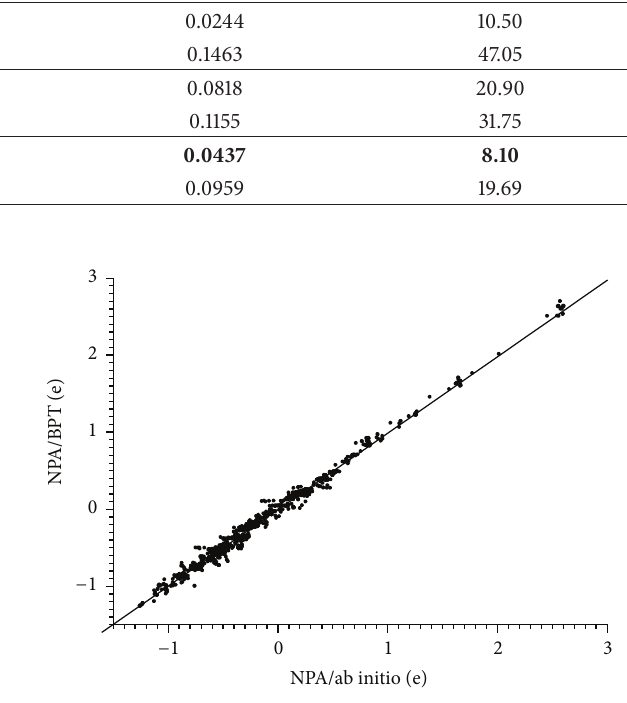
Figure 1: Correlation of NPA atomic charges calculated with BPT and DFT employing a 6-31G(d,p) basis set. The calibration set included 175 compounds containing the elements H, C, N, O, F, Si, P, S, Cl, and Zn. The correlation coefficient is 𝑅 = 0.9961 and the standard deviation SD = 0.05